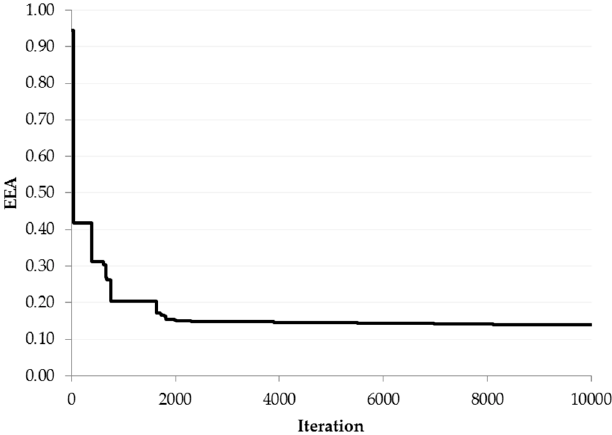
Figure 8. Behavior of the scale parameters for the EV1-3P with respect to the iterations of ( a ) λ 1 ; ( b ) λ 2 ; and ( c ) λ 3 for hydrometric station 10040.